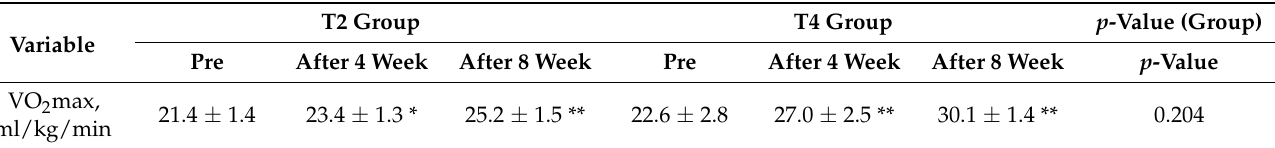
Table 4. Changes in VO 2 max in both